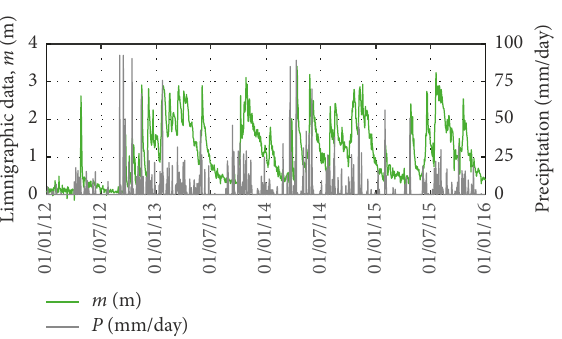
Figure 3: Discharge hydrograph of the Golubinka spring in the analyzed